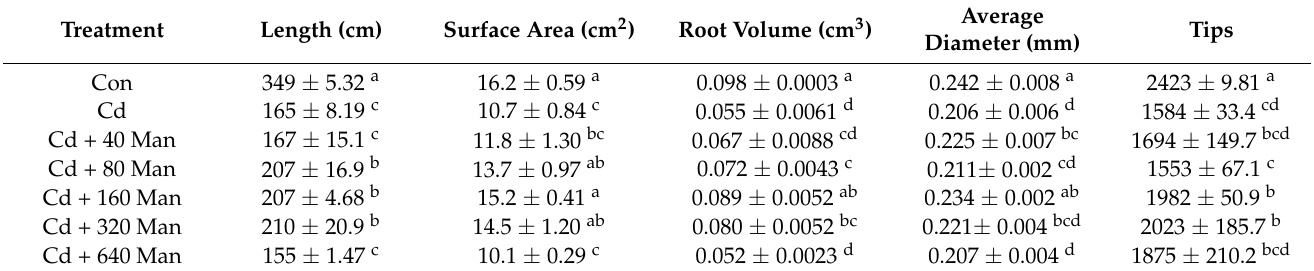
Table 2. Effects of different concentration of MAN on wheat total length, surface area, volume, average diameter, and tips under Cd stress.